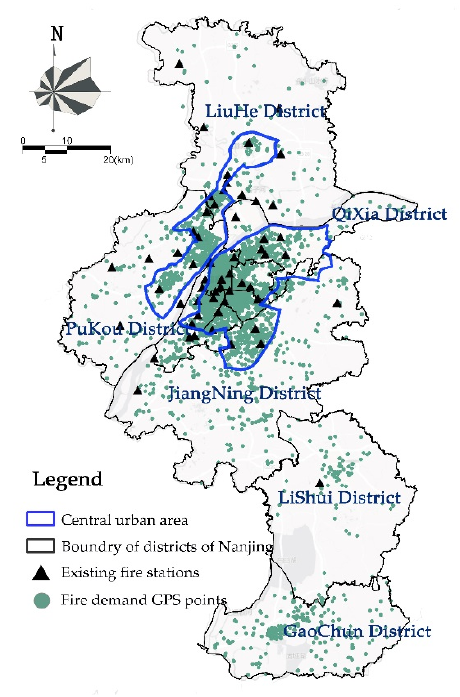
Figure 3. The fire outbreak locations and current fire stations in